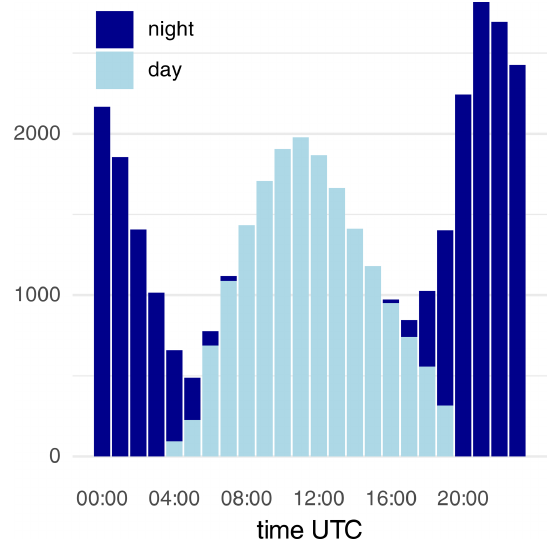
Figure 3. Number of complete clear-air radar echoes at the 12 se- lected radar stations, shown separately for night and day as defined by sunrise and sunset.